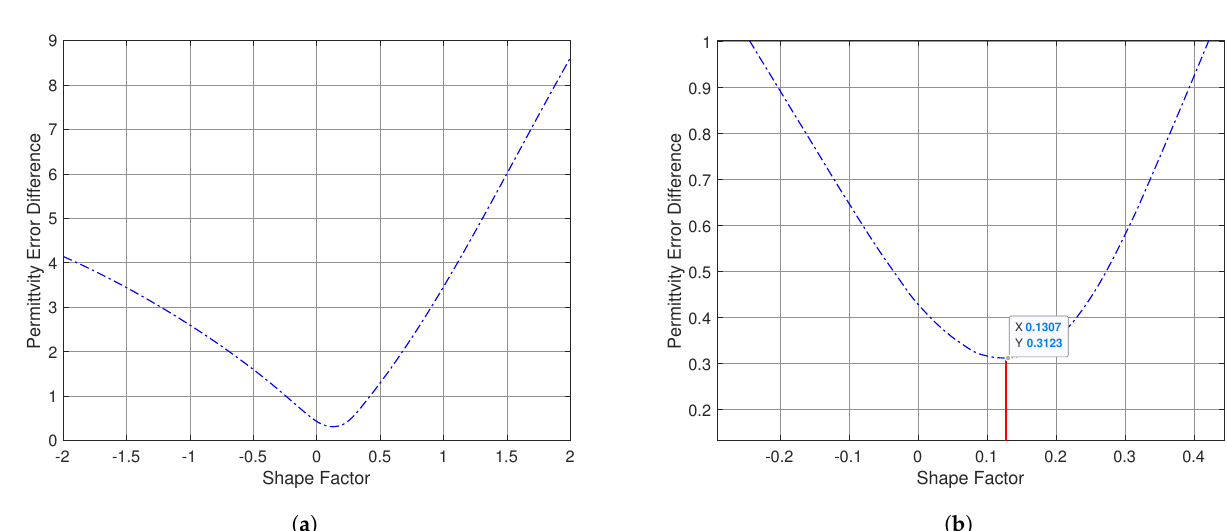
Figure 5. The error betweenthe estimated permittivity using Finite-Difference Time-Domain (FDTD) and Complex Refractive Index Model (CRIM) models ( a ). Sub-figure ( b ), zooms in to better visualise the resulting shape